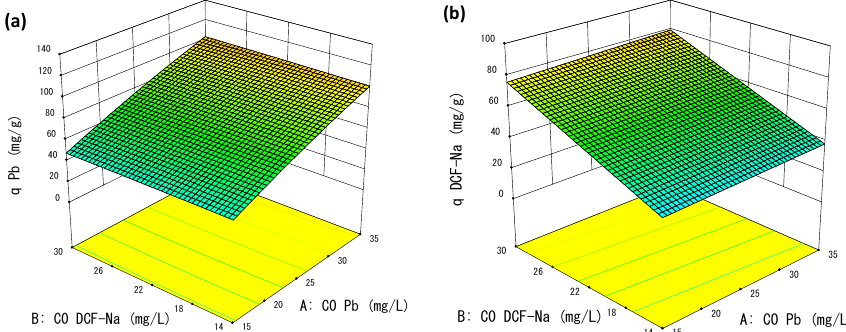
Figure 8. Three-dimensional response surface of the effect of lead ions and DCF-Na initial concentra- tions (at a temperature of 20 ◦ C) on the simultaneous sorption process: ( a ) q Pb and ( b ) q DCF-Na